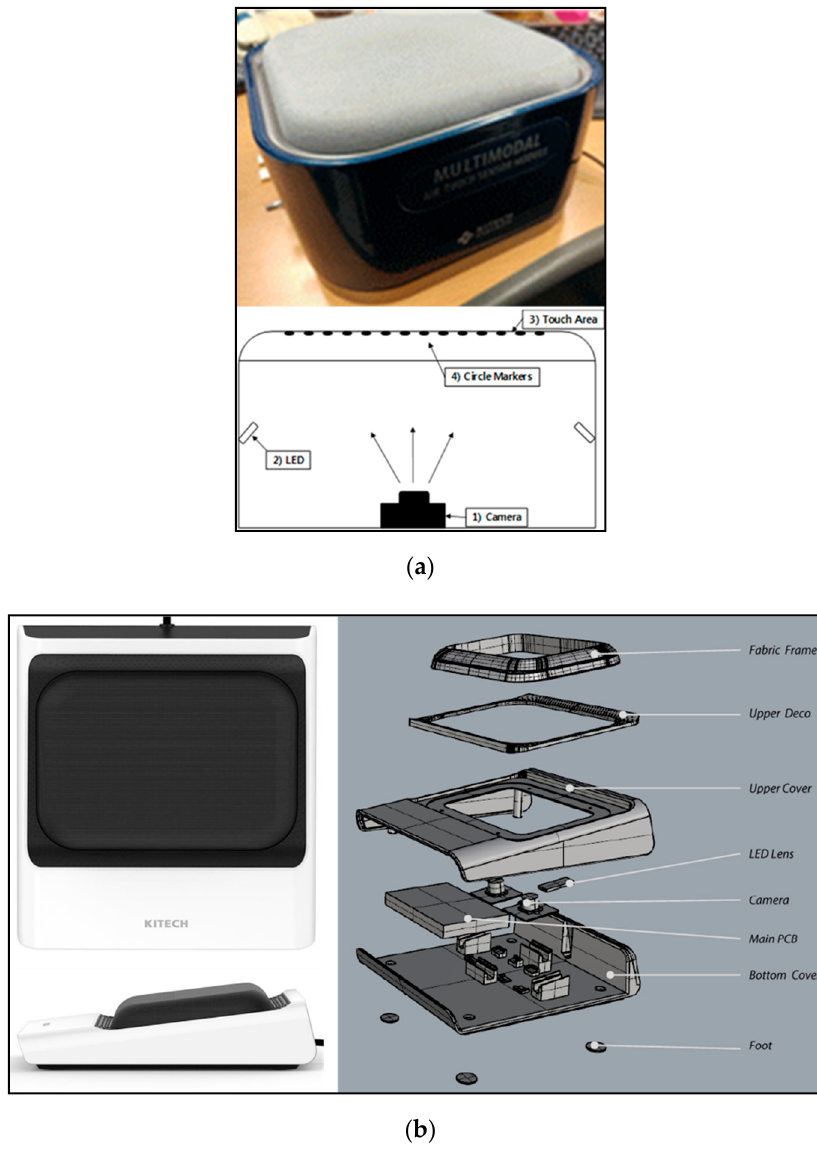
Figure 1. Two types of image-based areal soft tactile sensor (IASTS) ( a ) single-camera model and ( b ) dual-camera model.